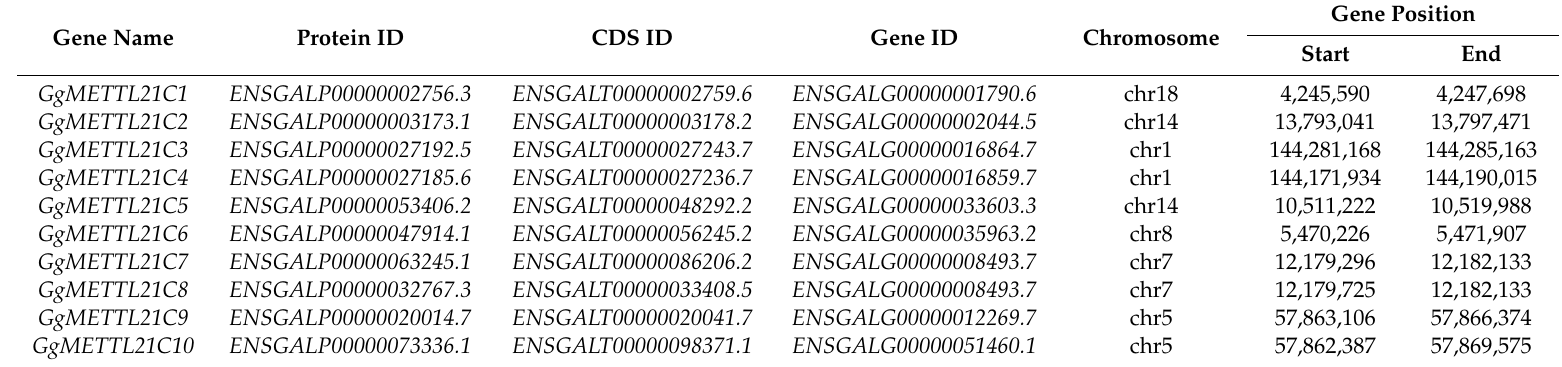
Table 1. Methyltransferase-like 21C ( METTL21C ) gene family information in chickens ( G. gallus